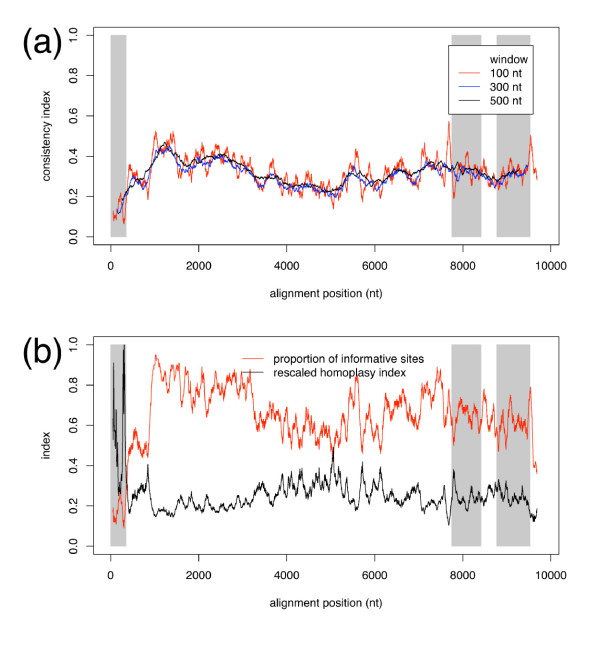
Consistency and homoplasy indices. Moving-window averages of (a) character consistency with the whole-genome phylogeny for windows of 100 (red), 300 (blue), or 500 (black) nucleotides and (b) proportion of informative sites (red) and rescaled homoplasy index (black) for windows of 100 nucleotides as a function of the window midpoint in the whole-genome alignment. Regions corresponding to the 5' UTR (left) and NS5B (right) are indicated with grey bands, with a white band in the middle of NS5B to indicate the 329 nt Okamoto region.